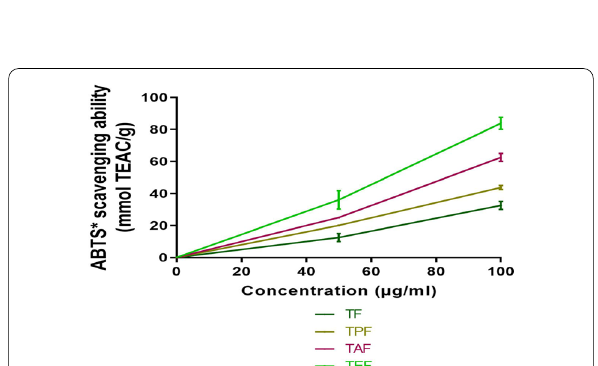
Fig. 5 ABTS* scavenging ability of native and modified tacca flour. TF: Native tacca flour, TPF: tacca physical flour, TAF: tacca acetylated flour, TEF: tacca enzymatic starch